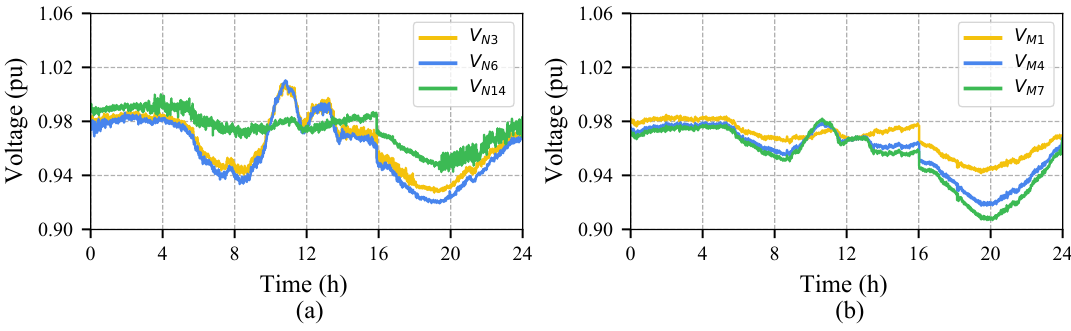
Figure 11. PSHIL-1. Impact on the MV and LV distribution networks. ( a ) 24-h evolution of the MV network voltages at buses N3, N6, and N14. ( b ) 24-h evolution of the LV network voltages at buses M1, M4, and